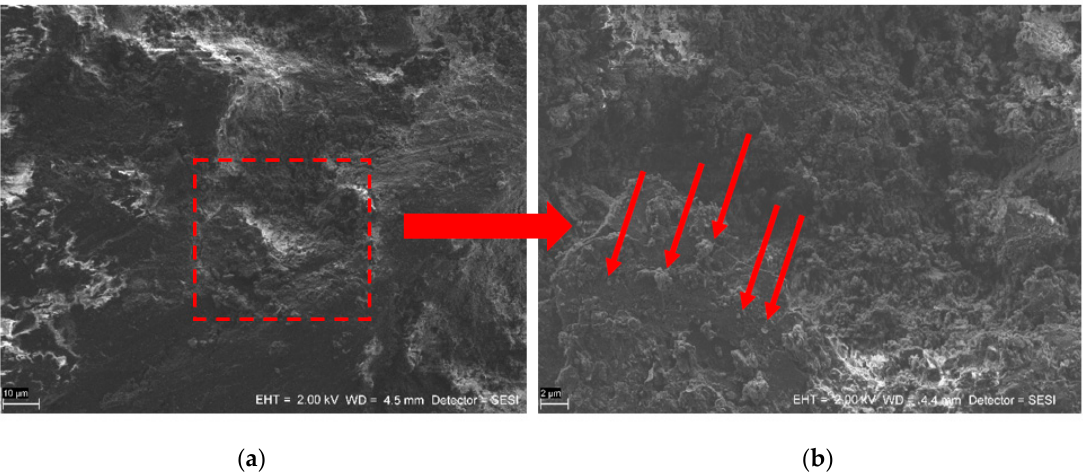
Figure 8. SEMimage of the sample surface (SESI detector at ETH=2.00 kV). ( a ) General view,( b ) magnification of the selected area. Red arrows indicate TiO 2 agglomerates on the observed surface.